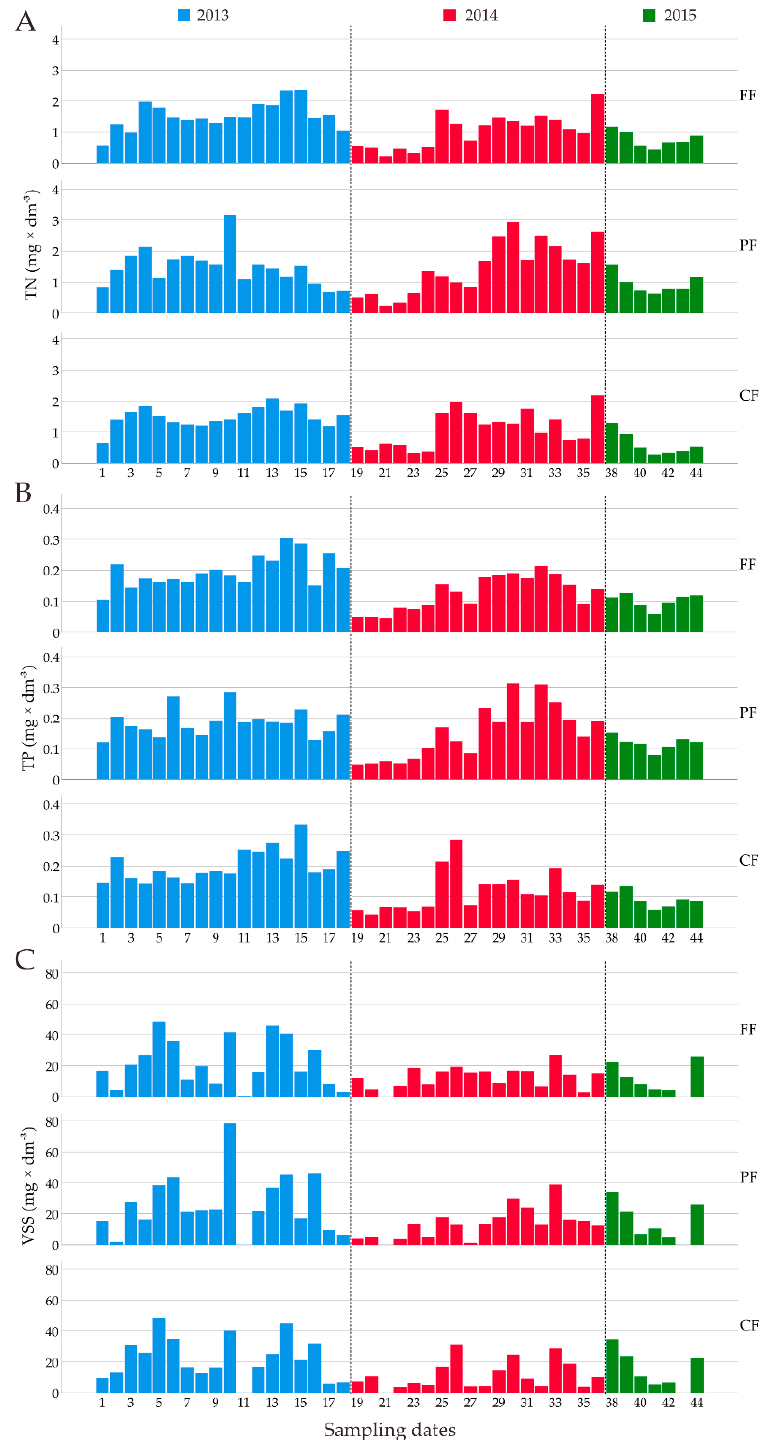
Figure 1. Annual profile of the three water quality variables (TN: total nitrogen, TP: total phosphorus, VSS: volatile suspended solids) in case of all three feed types (FF: feed with fish meal, PF: plant-based feed, CF: cereal feed). Figures were generated by the IBM SPSS software package (version 25).